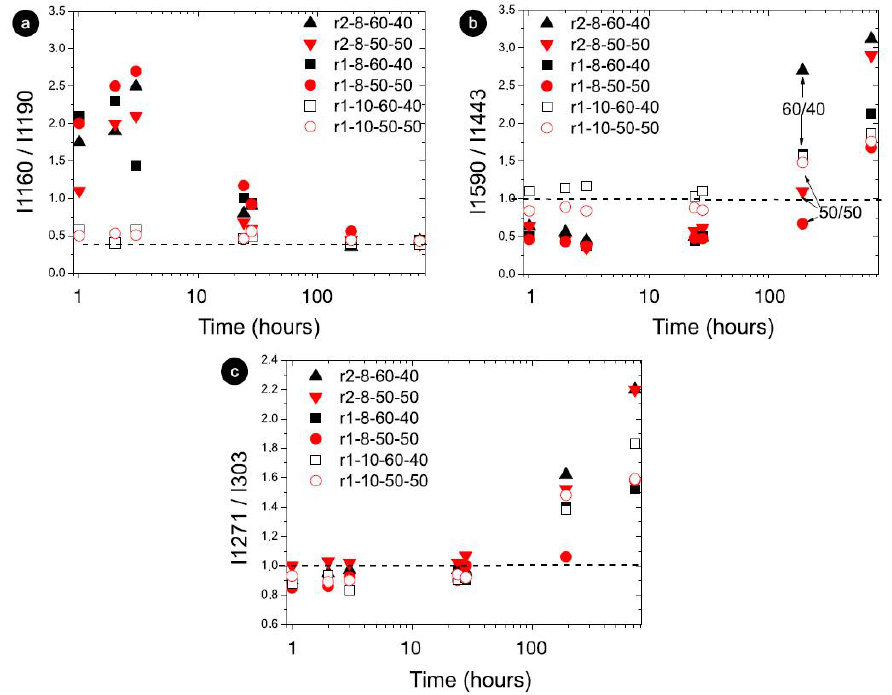
Figure 4. Raman modes with the most intensity variation as a function of storage for STO8 samples, and for r1-STO10 (50:50 and 60:40); 10 wt% (open symbols) and 8 wt% (full symbols); red and black colors represent 50:50 and 60:40 ratios, respectively. xx axis on a logarithmic scale. The horizontal dashed line indicates ( a ) the final condition reached; ( b , c ), the value 1 for the intensity ratio (meaning equal intensity).